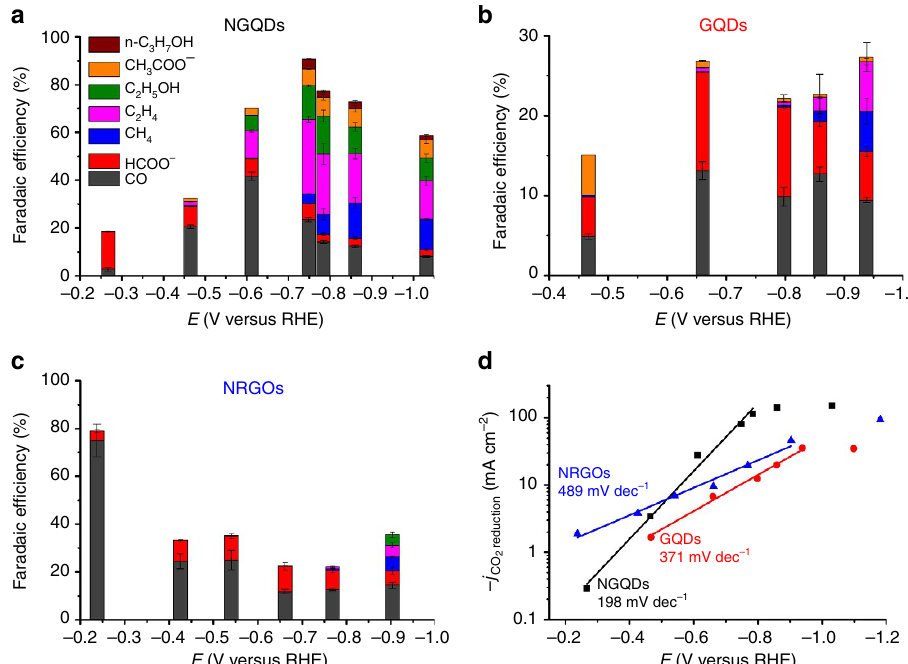
Figure 2 | Electrocatalytic activity of carbon nanostructures towards CO 2 reduction. ( a ) FEs of carbon monoxide (CO), methane (CH 4 ), ethylene (C 2 H 4 ), formate (HCOO (cid:2) ), ethanol (EtOH), acetate (AcO (cid:2) ) and n-propanol (n-PrOH) at various applied cathodic potential for NGQDs. ( b ) FE of CO 2 reduction products for pristine GQDs. ( c ) Selectivity to CO 2 reduction products for NRGOs. ( d ) Tafel plots of partial current density of CO 2 reduction versus applied cathodic potential for three nanostructured carbon catalysts. The error bar represents the s.d. of three separate measurements for an electrode.